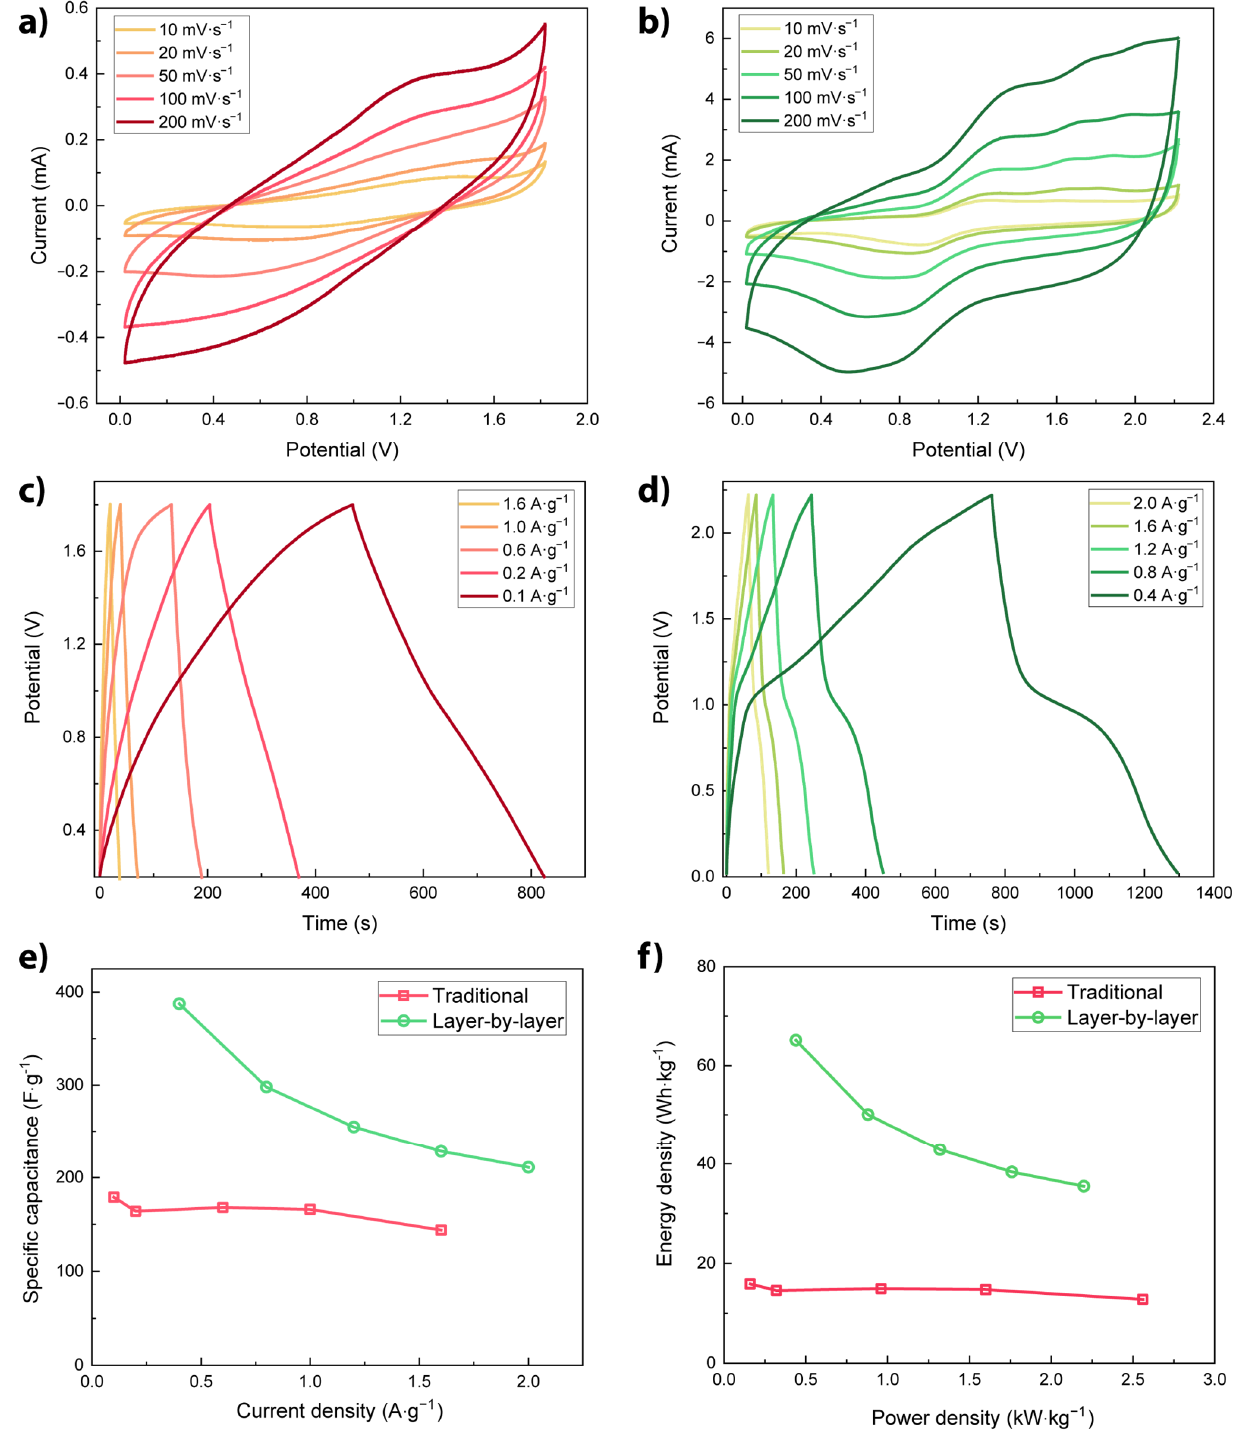
Figure 3. Cyclic voltammograms (scan rates 10 to 200 mV s − 1 ) of SCs composed of Per-TAPB-PPI -based electrodes prepared via ( a ) a traditional mixing method or ( b ) a layer-by-layer method. Galvanostatic charge–discharge profiles at different current densities of Per-TAPB-PPI -based elec- trodes prepared via ( c ) a traditional mixing method or ( d ) a layer-by-layer method. ( e ) Corresponding specific capacitance at different current densities. ( f ) Energy and power densities of SC devices.